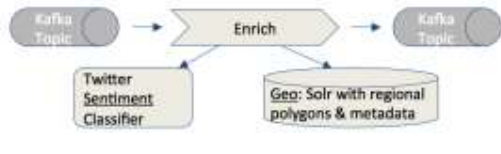
Figure 2. Process for enrichment in